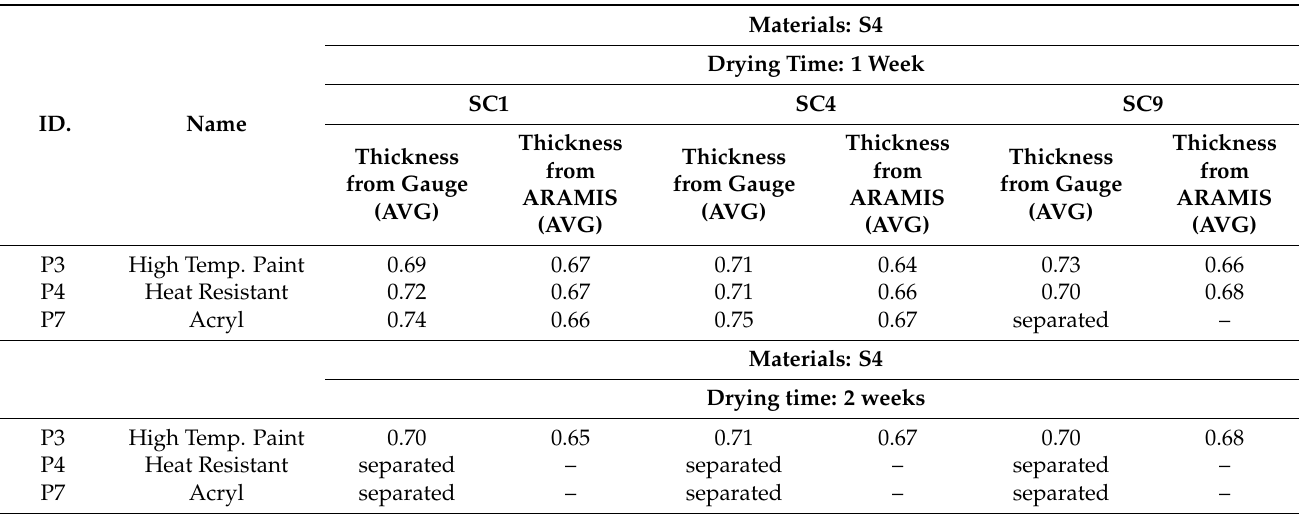
Table 14. Measurement results of durability tests.